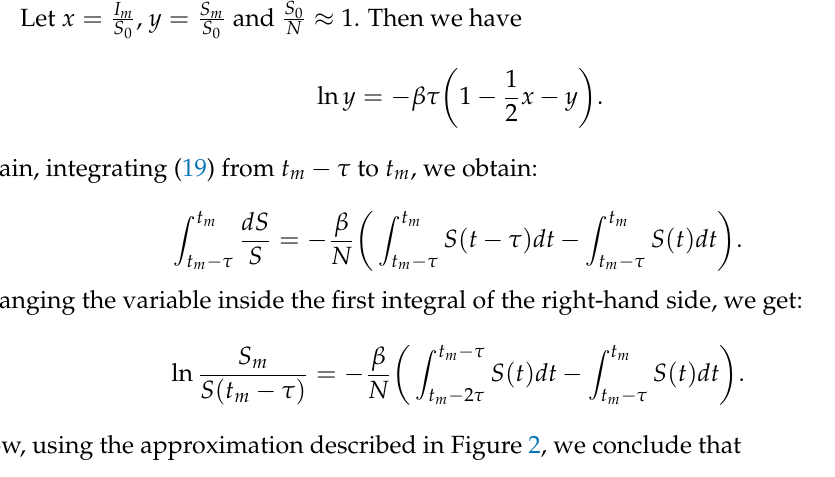
Figure 2. The red curve represents S ( t ) . The integral (yellow color region + cyan color region), is approximated by the sum of the areas of the cyan color region, the yellow color region, and the green color